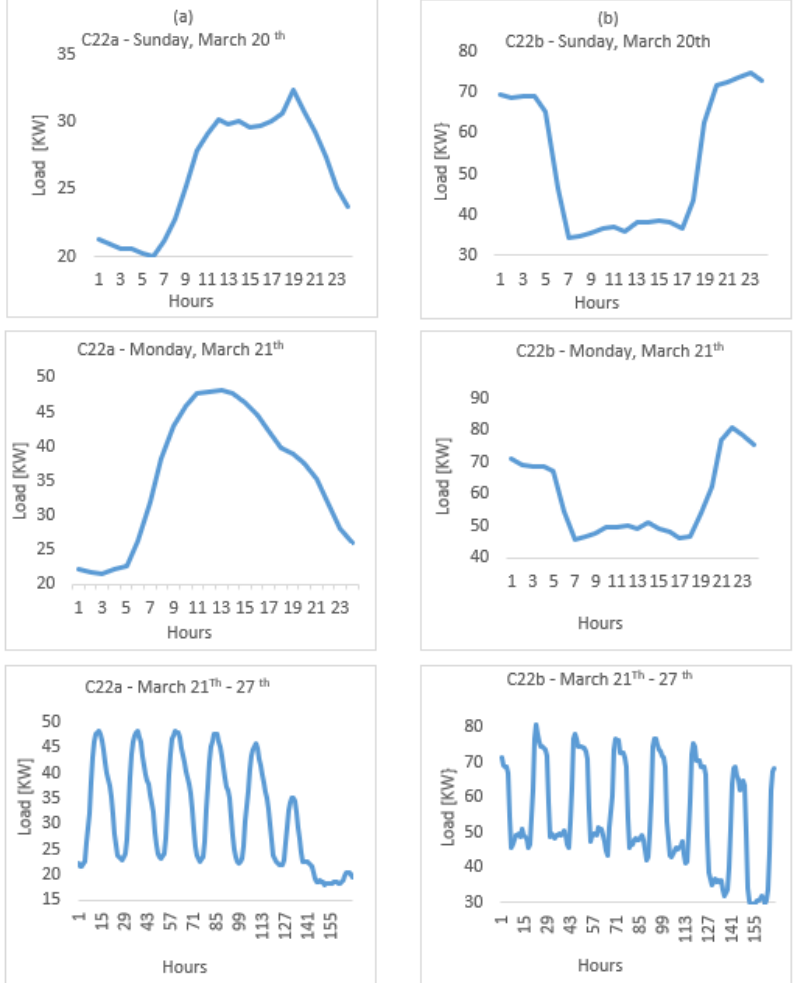
Figure 4. Daily and weekly energy consumption structures of two different users: ( a ) user C22a, ( b ) user